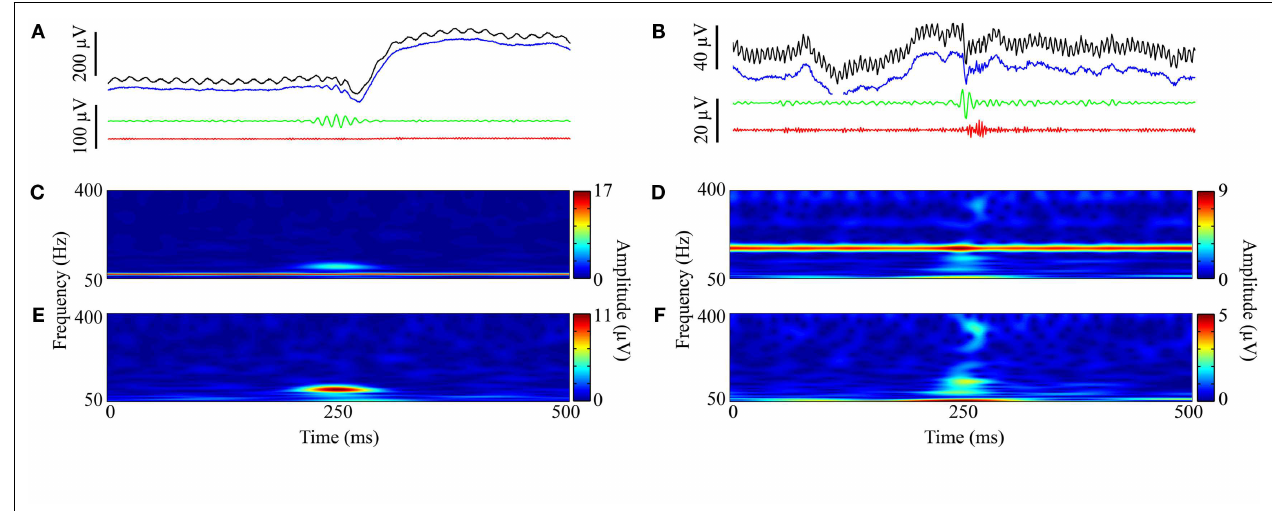
ripple-band passed (80–200Hz) signal (green), and (4) SN and fast ripple-band passed (250–450Hz) signal (red). For both (A) and (B) , the y-axis of black and blue traces are scaled separately from green and red traces. (C,D) and (E,F) are the spectrograms of the corresponding unfiltered signal (black) and SN-filtered signal (blue),